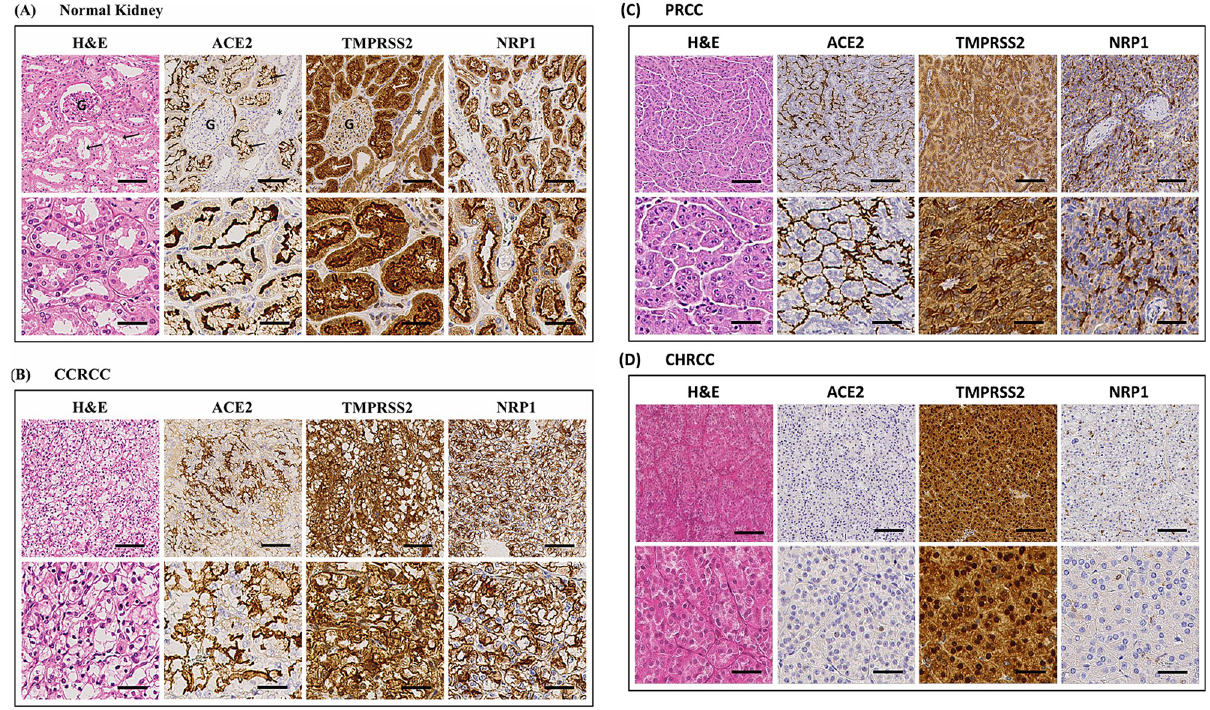
Fig 2. Expression of ACE2, TMPRSS2 and NRP1 in normal kidney and renal cell carcinoma tissue. Haematoxylin & eosin staining of tissues and immunohistochemistry staining for ACE2, TMPRSS2 and NRP1. (A) Normal kidney displays staining of the apical plasma membranes of the proximal tubules for all three proteins. G = glomerulus, arrows = examples of proximal tubules and asterisk = collecting duct (negative). (B) Clear cell renal cell carcinoma tissue shows a diffuse staining of the plasma membranes for ACE2, TMPRSS2 and NRP1. (C) Papillary renal cell carcinoma displays an apical staining pattern for all three proteins. The lower rows of the panels show higher magnification of the images above. (D) Chromophobe renal cell carcinoma displayed negative staining for ACE2 and NRP1 whereas TMPRSS2 was strongly positive in the cancer cells. Upper panel scale bar = 100 μ m, lower panel scale bar = 40 μ m. (CCRCC = clear cell renal cell carcinoma, PRCC = papillary renal cell carcinoma, CHRCC = chromophobe renal cell